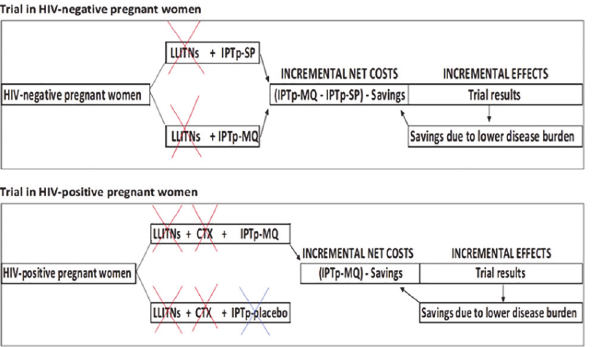
Fig 1. Design of the Incremental economic evaluation. HIV = Human Immunodeficiency Virus; LLITNs = Long-Lasting Insecticide Treated Nets; CTX = Cotrimoxazole; IPTp = Intermittent Preventive Treatment of malaria in pregnancy; SP = Sulphadoxine-Pyrimethamine; MQ = Mefloquine. The figure shows that for both Trials the cost of LLITNs was not considered in the economic evaluation performed as women in both arms were administered with this preventative tool. The same applies for CTX in Trial on HIV-positive women. IPTp-placebo in Trial on HIV-positive women was considered as “ doing nothing ” option with no costs associated. Incremental net costs were calculated, which included the incremental costs of the intervention minus treatment savings due to its efficacy.